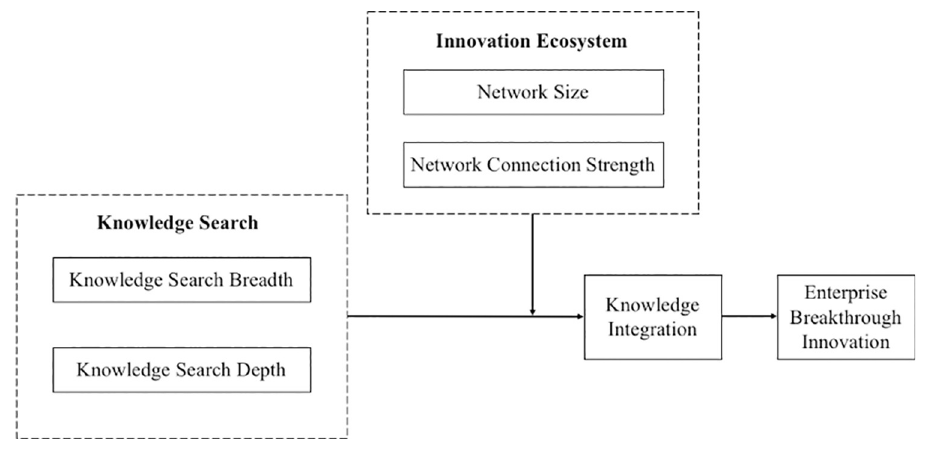
Fig 1. Conceptual